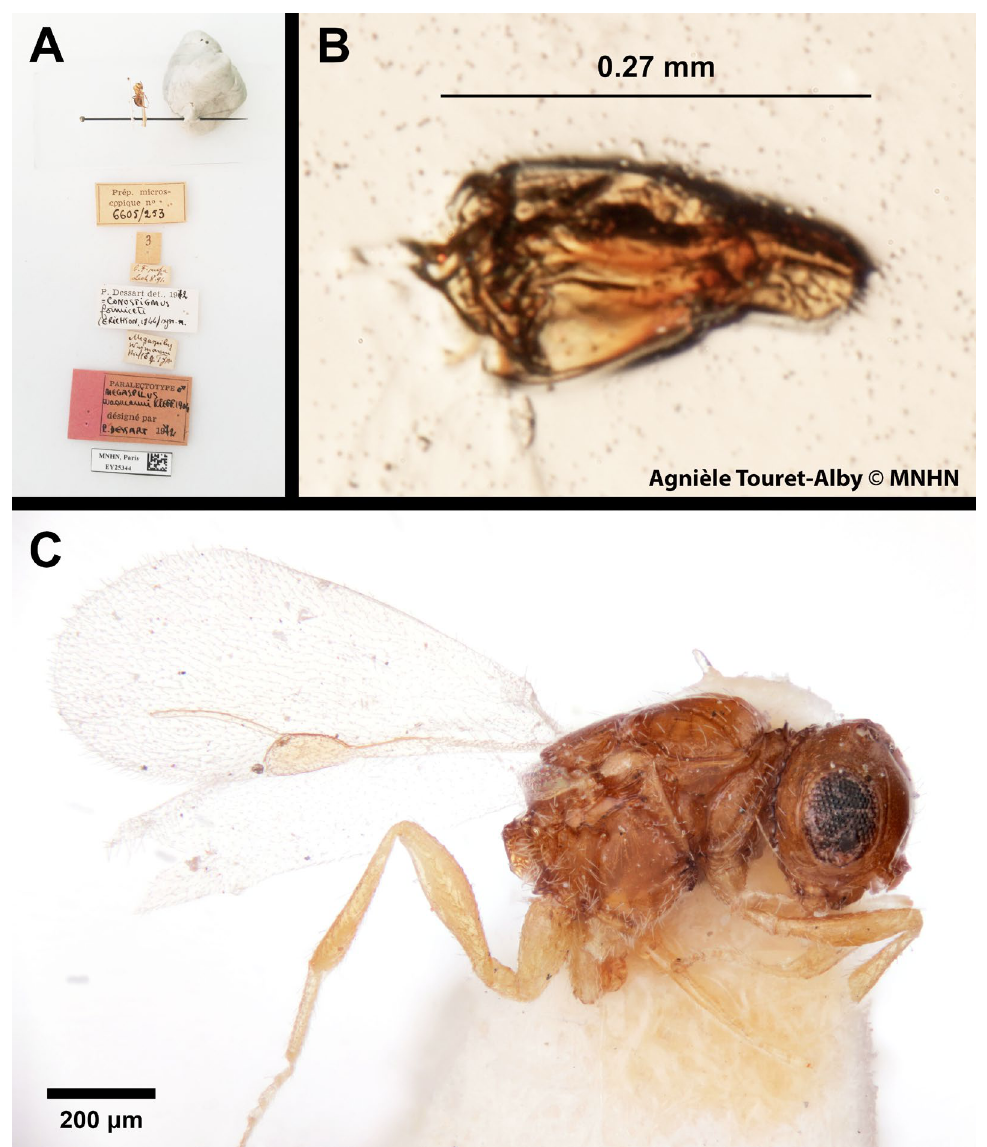
Fig. 17. Megaspilus wasmanni kieffer, 1904, synonym of Conostigmus formiceti (Erichson, 1844), paralectotype, ♂ (MNHN EY25344). A . Labels B . Lateral view of the male genitalia, imaged by Agnièle Touret-Alby © MNhN. C . Lateral